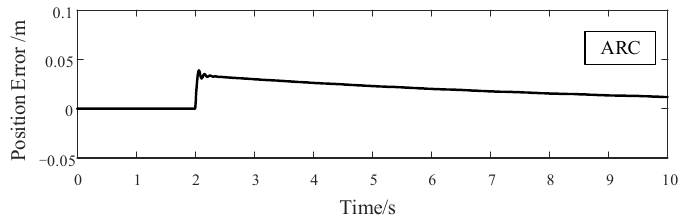
Figure 12. ARC Tracking Error of 1 Hz Sinusoidal Signal with 700 N External Disturbance.